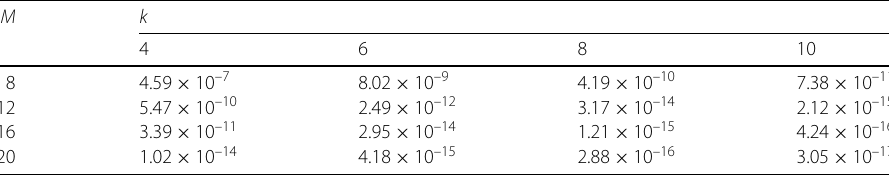
Table 5 Maximum absolute errors at different values of M and k for Example 7.4 via